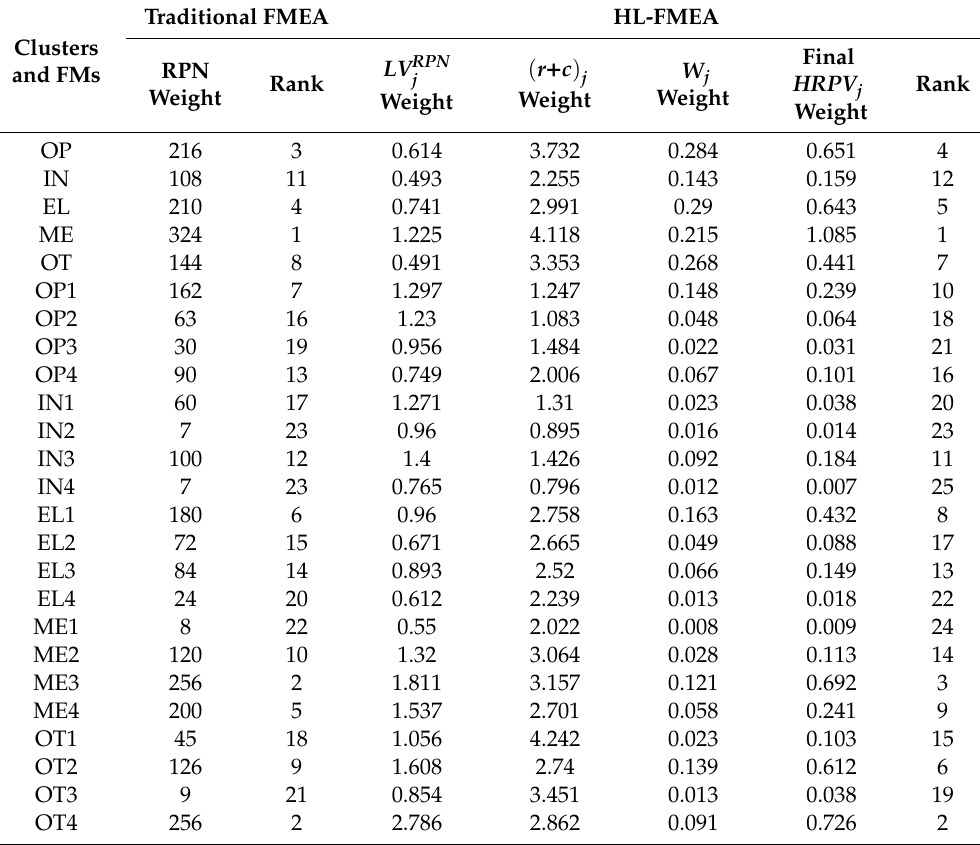
Table 3. Final hybrid risk value of clusters and